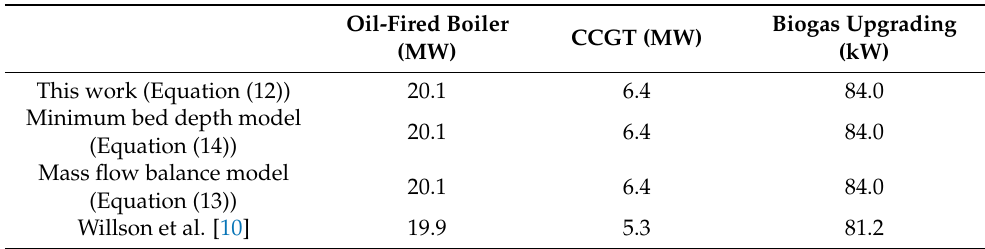
Table 10. Comparison of energy duty of the desublimer calculated through different energy balance